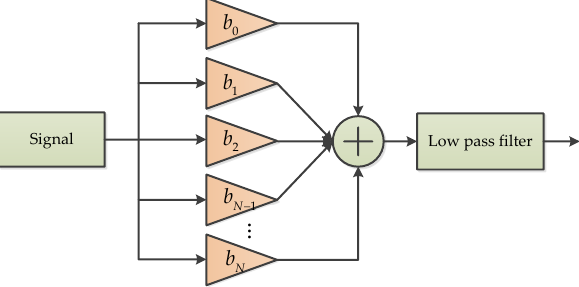
Figure 5. The process of Variable bandwidth filtering.